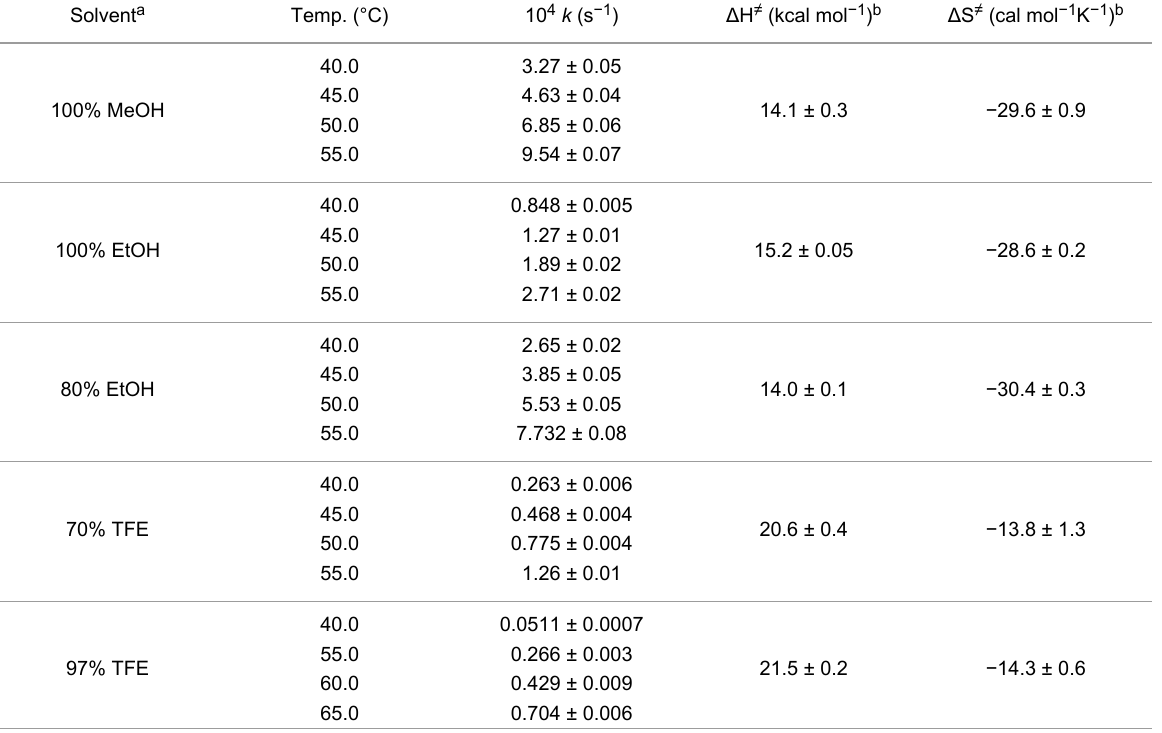
Table 2: Specific rates for solvolysis of isobutyl chloroformate ( 1 ) at various temperatures and the enthalpies and entropies of activation. Solvent a Temp. (°C)